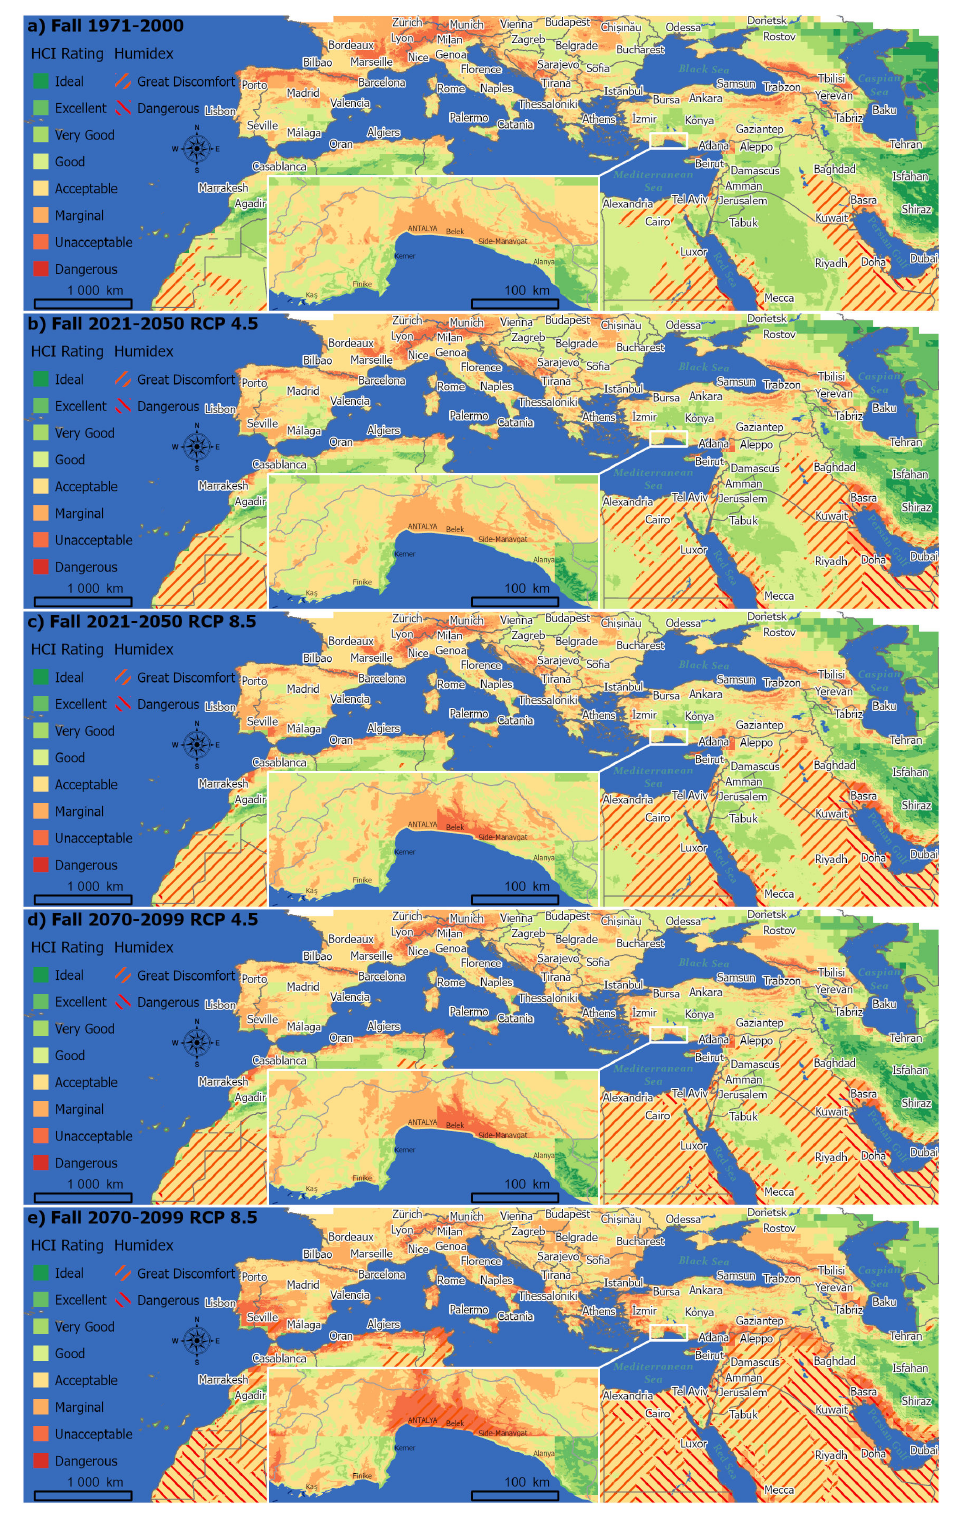
Figure 3. Fall season Holiday Climate Index (HCI) ratings and Humidex risks in the greater Mediterranean region for the projection periods ( a ) 1971–2000 ( b ) 2021–2050 (RCP 4.5) ( c ) 2021–2050 (RCP 8.5) ( d ) 2070–2099 (RCP 4.5) ( e ) 2070–2099 (RCP